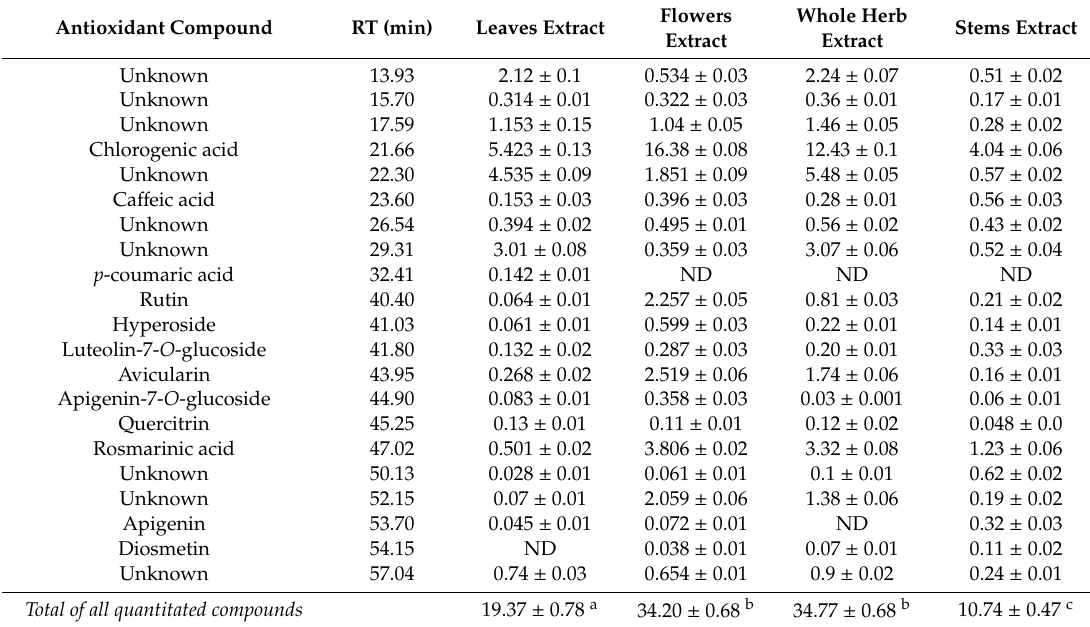
Table 3. Trolox equivalent (TE) values (µmol/g of DW) of E. ciliata ethanolic extracts in ABTS post- column assay.